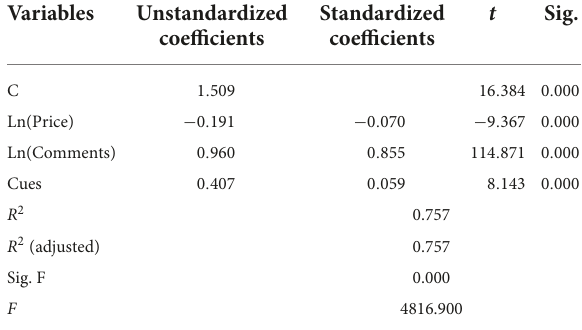
TABLE 1 Results of haptic cues influence in glove